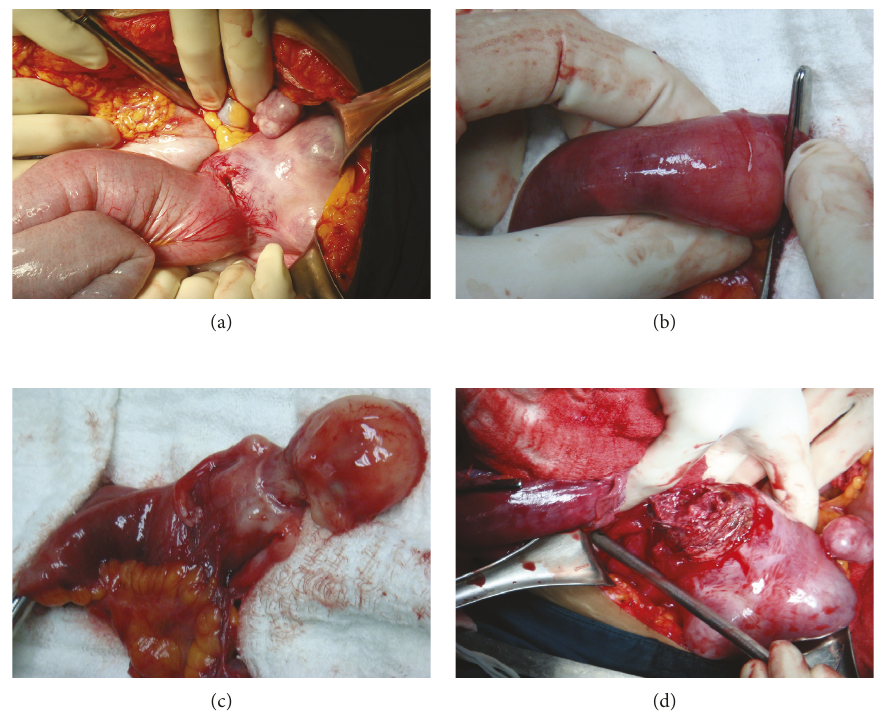
Figure 1: Photographs of intraoperative findings. (a) Exploratory laparotomy showing the adherence between the ileum and uterine fundus. (b) The intraluminal ileal mass palpable near the adherence site. (c) The opened ileum revealing a dead fetus. (d) Photograph showing the placenta in the uterus after detaching the ileum from the uterine fundus.